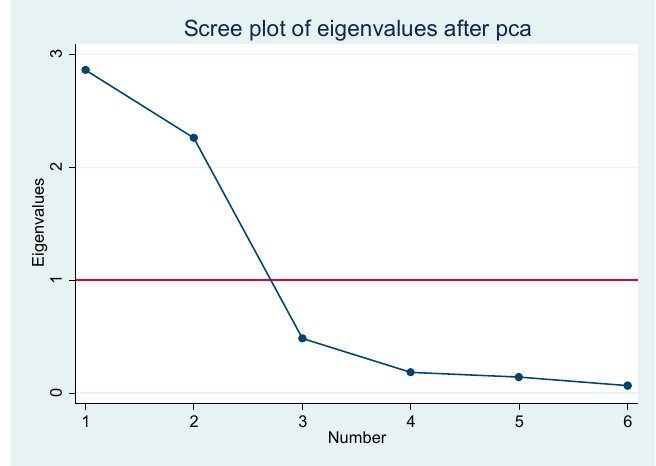
Figure A1. Scree plot of eigenvalues. PCA: principal component analysis.